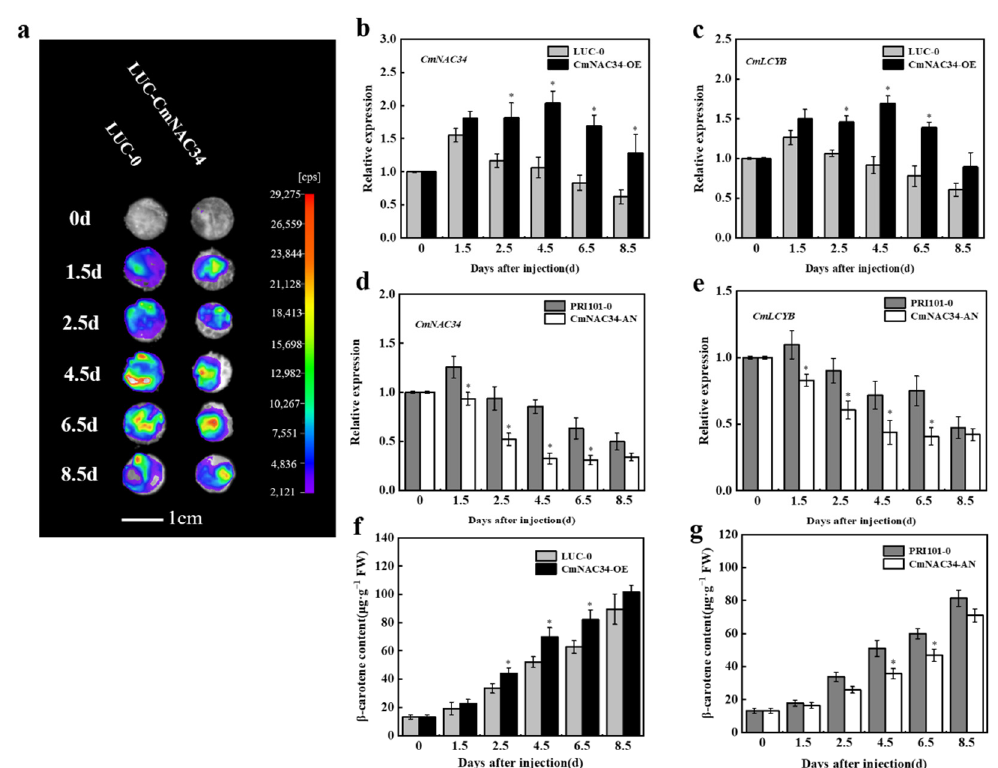
Figure 4. CmNAC34 was transiently expressed in oriental melon and β -carotene concentration in transiently transgenic fruit. ( a ) The luciferase intensity was detected in LUC-0 and LUC-CmNAC34 fruit at different days after infiltration. ( b , c ) The relative expression of CmNAC34 and CmLCYB in oriental melon fruit overexpressed CmNAC34 and fruit infiltrated with LUC-0. ( d , e ) The relative expression of CmNAC34 and CmLCYB in oriental melon fruit silenced CmNAC34 and fruit infiltrated with PRI101. ( f ) The β -carotene concentration of transient overexpression of CmNAC34 and LUC-0 fruit were measured using HPLC. ( g ) The β -carotene concentration of transient silence of CmNAC34 and PRI101fruit were measured using HPLC. The data were analyzed from three biological replicates, and the error bar represents the SE. Asterisks indicate a significant difference compared to control, as determined by the independent sample t -test (* p < 0.05).